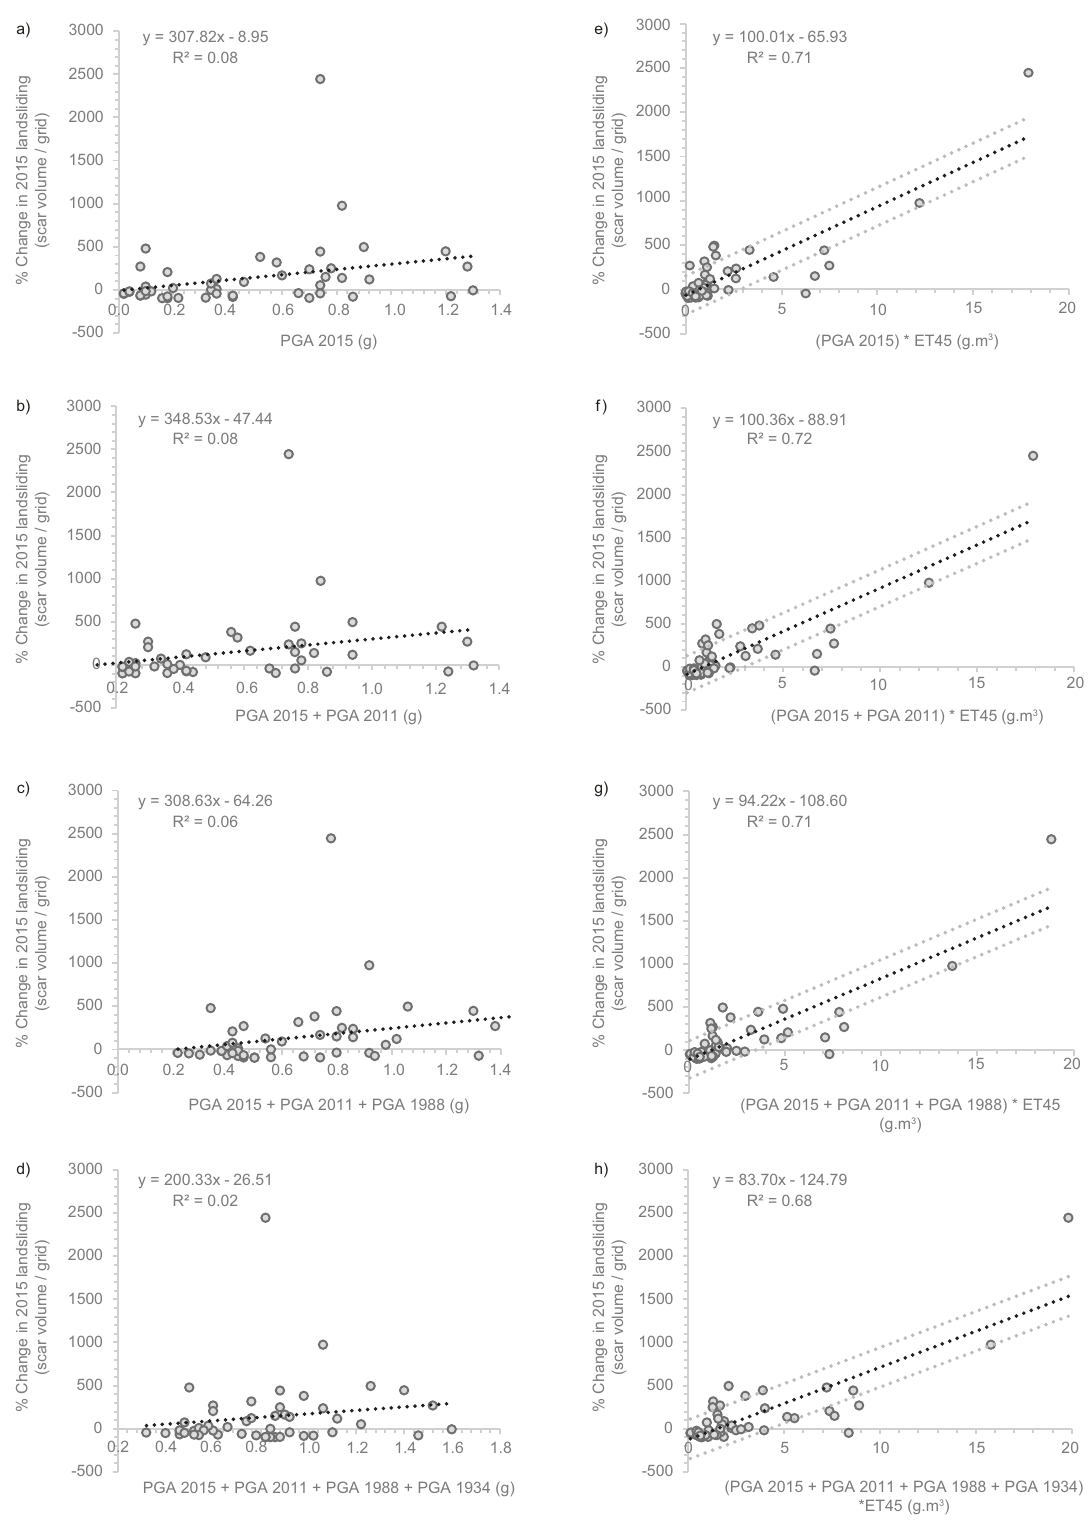
Fig. 8 Correlations between maximum summed PGA and percentage change in monsoon-triggered 2015 mass-wasting. This is shown for a PGA in the 2015 main shock and largest aftershock. b the summed PGA from a plus the PGA from 2011. c The summed PGA from b plus the PGA from 1988. d The summed PGA from c plus the PGA from 1934. e – h show the same correlations as a – d , but with summed PGAs multiplied by excess topography above a threshold angle of 45°. The linear best fi ts are shown with ±1 standard error in each